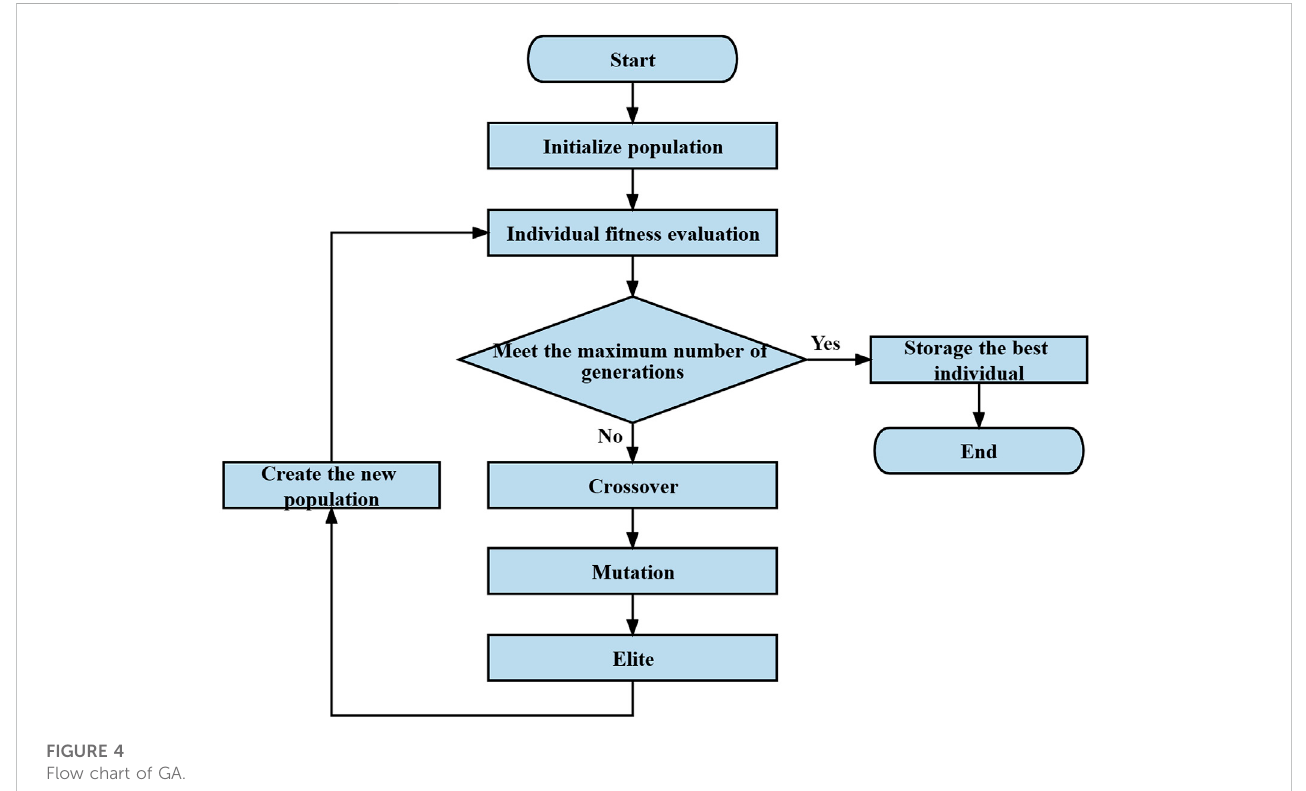
FIGURE 4 Flow chart of